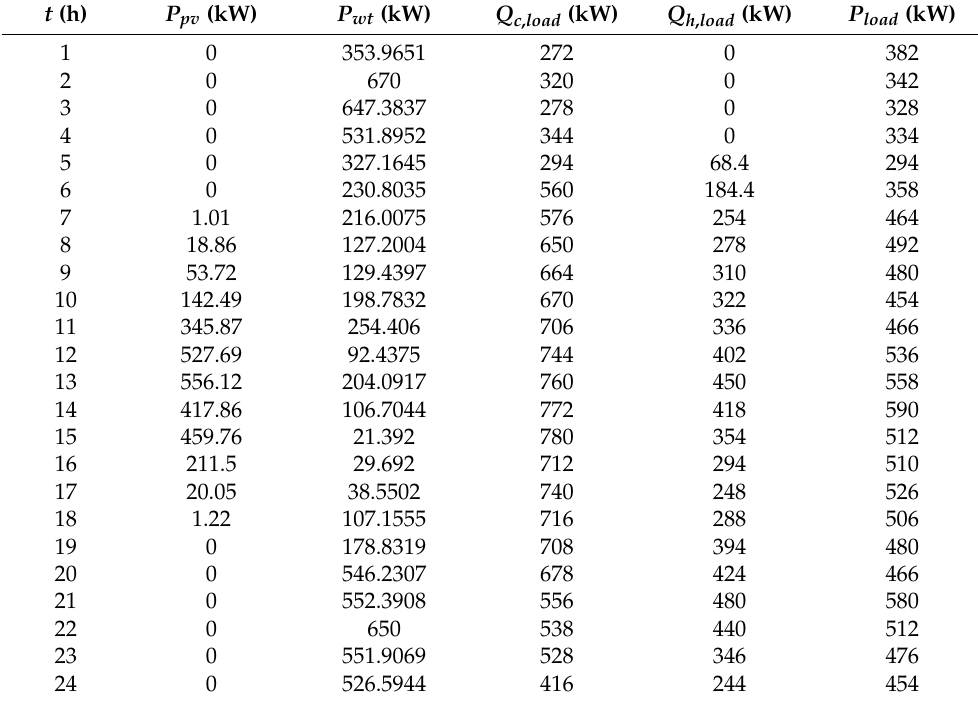
Table 7. Forecast values of wind turbine, photovoltaic, and load outputs on a typical day in summer.